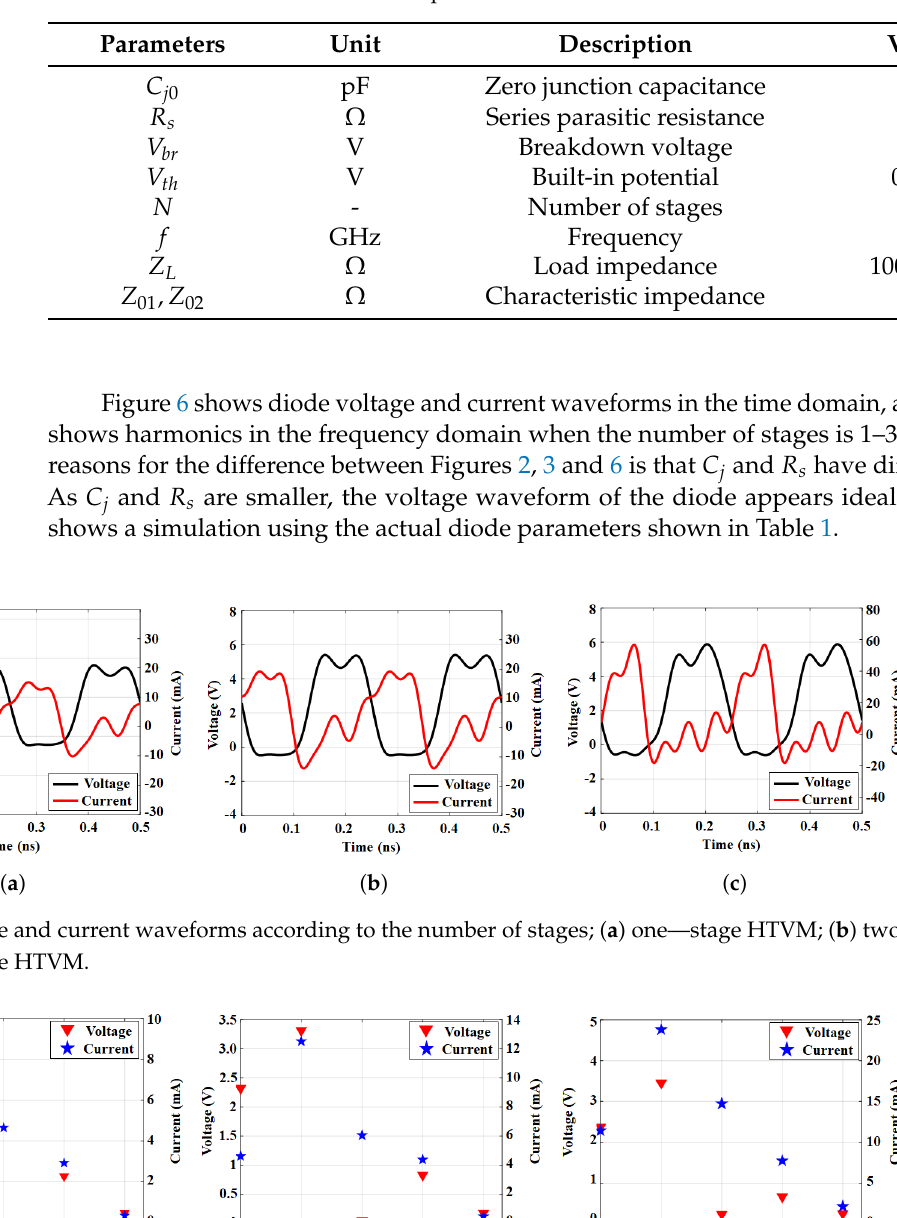
Table 1. Simulation and measurement parameters.